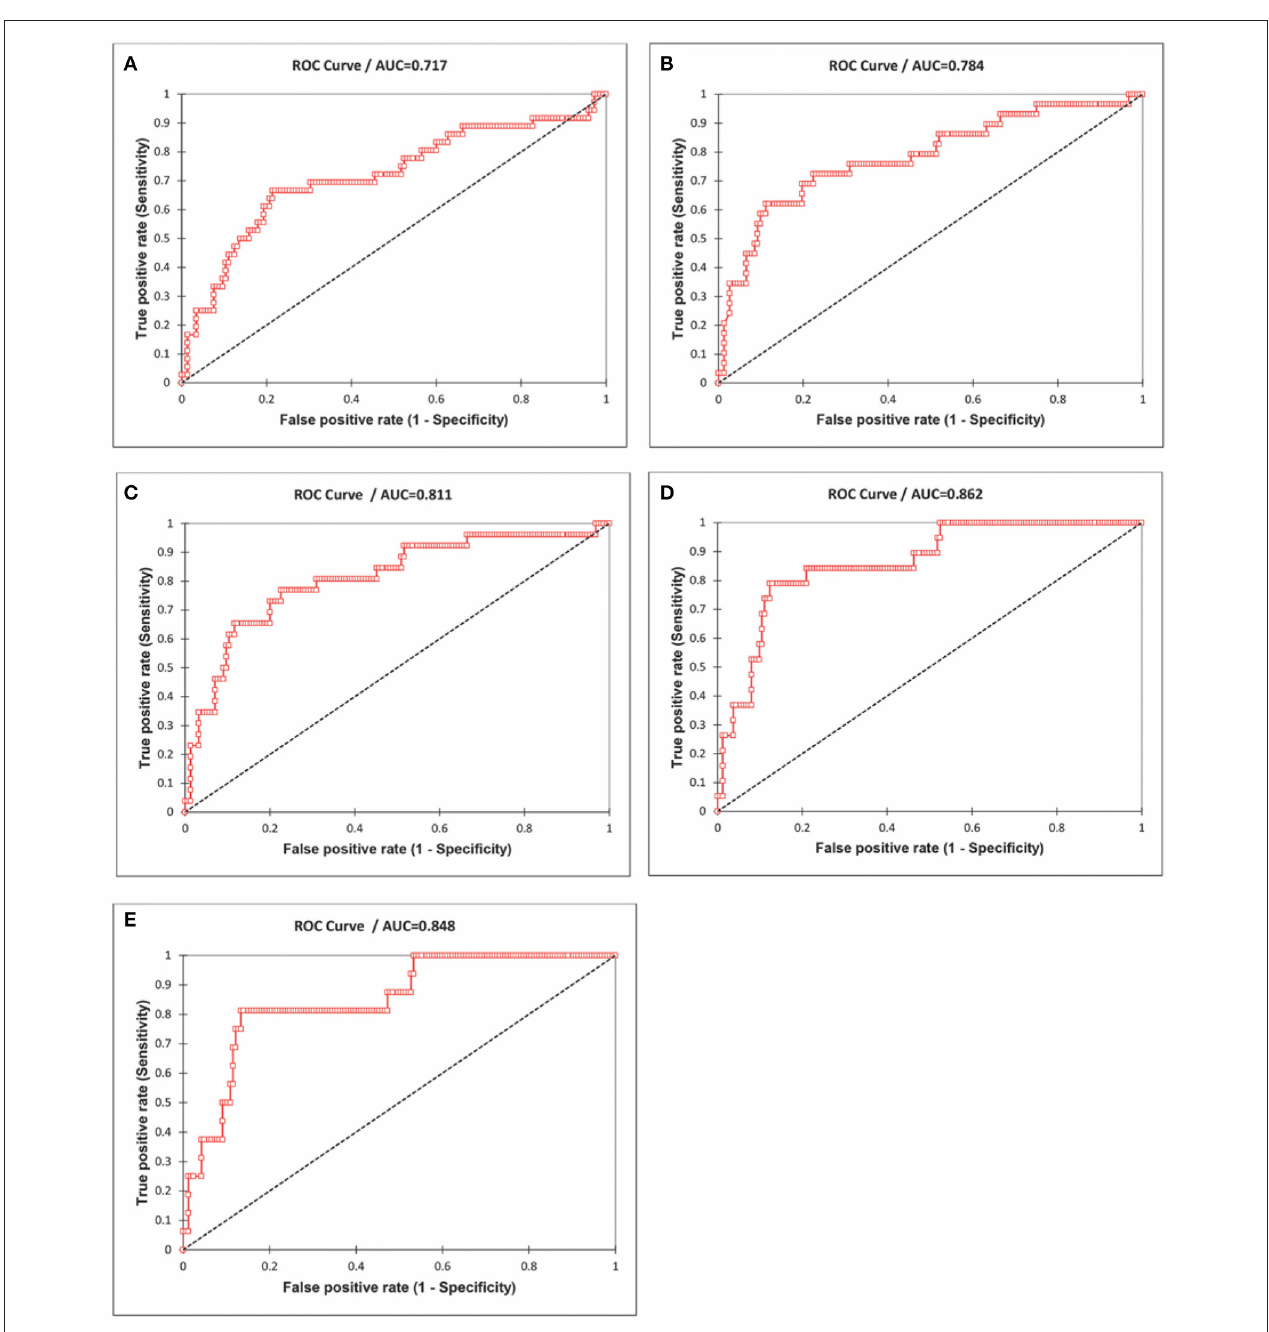
FIGURE 10 | Receiver Operating Characteristics (ROC) curve analysis of the influenza incidence and the mortality rates of COVID-19 (cut-off mortality rate at 50/million, area under the curve-AUC 0.72; (A) 75/million, AUC 0.78, (B) 100/million, AUC 0.81, (C) , 150/million, AUC 0.86, (D) 200/million, AUC 0.85, and (E)